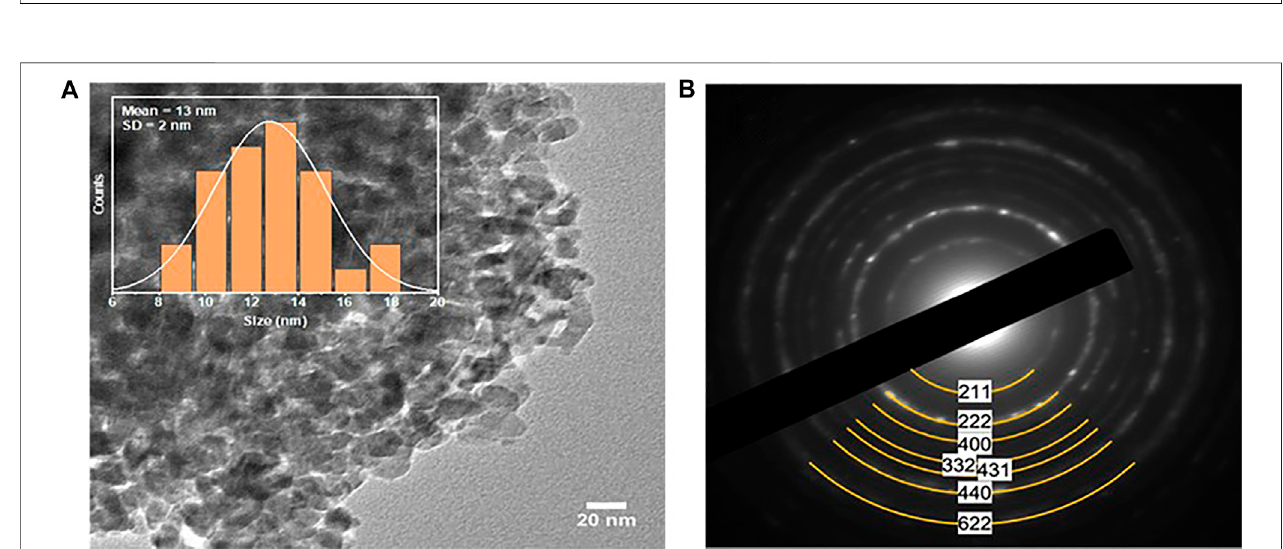
FIGURE2|(A) RepresentativeTEMimage(insetsizedistributionhistogramoftheFeMnO 3 NPs,showinganaveragediameterof13 ± 2 nm),and (B) SAEDpattern of the as-synthesized FeMnO 3 NPs obtained at 450 ° C.